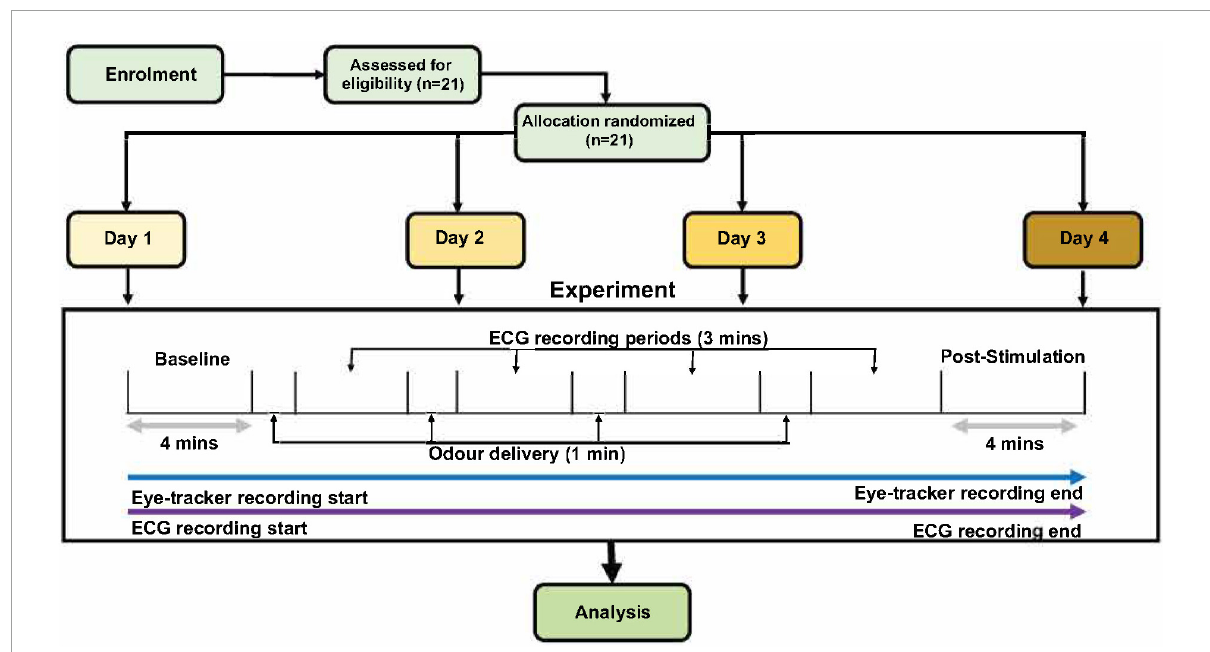
FIGURE1 The schematic for the experimental procedures. After 4 min of baseline recording, each participant received four different odor stimuli (low, moderate, and high concentration of one odor, and one sham stimulation with distilled water). Only one odor was present per day; therefore, the three concentrations present on each day were of the same odor (either lavender, jasmine, mushroom or rose) but in three concentrations and one sham. Order of days and odor stimuli were randomized across all the participants. Odor presentation was for 1 min per odor delivery, with 3-min inter-stimulus wash-out periods. Finally, there were a 4-min post-stimulation period to conclude each of the experimental days. The only difference in experiment design for the male and female cohorts was that, in the female cohort, this experiment was repeated two times in two stages of the menstrual cycle (follicular and